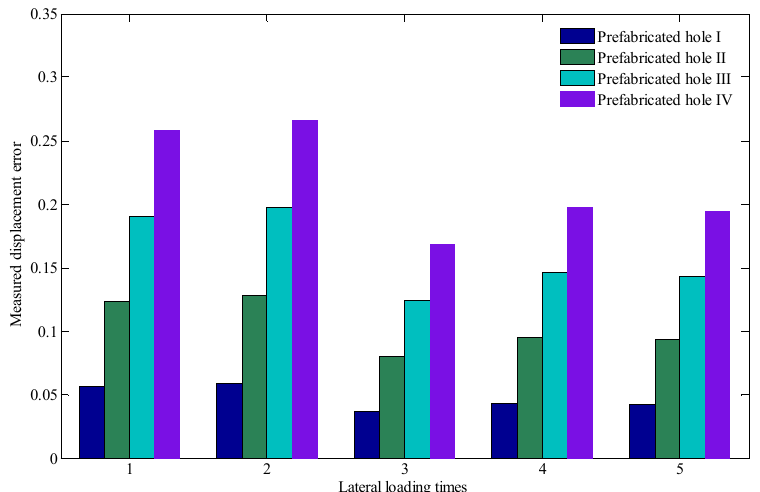
Figure 13. Measurement errors between the lateral loading displacement and displacement of the slope mass at the four prefabricated holes.